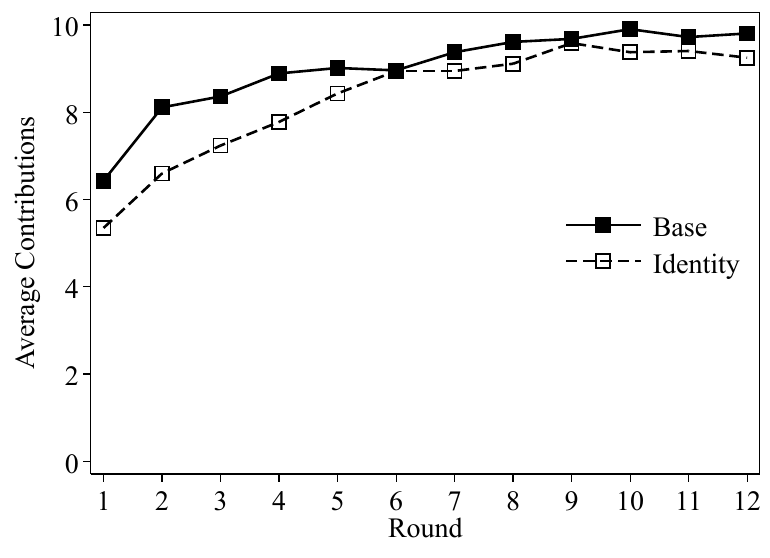
Figure 1. Time-path of the Average Contribution by